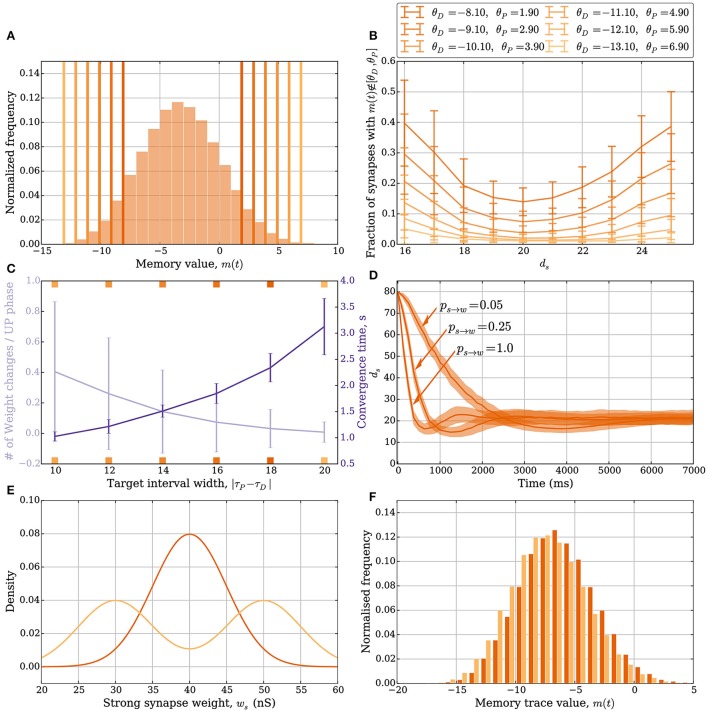
Plasticity vs. stability in the model with leak (Section 3.2.1). (A) Distribution of the memory trace in a static setting, with ps→w = pw→s = 0 and ds = 20 strong input synapses. The colored vertical bars represent the target interval [θD, θP] used in (B,C). (B) The mean fraction of synapses whose memory trace lies outside the interval [θD, θP] in a static setting. (C) The trade-off between the number of weight changes in the stable state and convergence time to the stable state. The light purple curve shows the mean number of weight changes per UP phase over all input synapses. The dark purple curve shows the mean time for the weights to converge from ds = 80 to ds = 25. The ticks on the x-axis are colored and correspond to the thresholds in (A) and curves in (B). In this setup, the number of strong synapses in the stable state is ds = 20. This is achieved by choosing ps→w and pw→s such that they satisfy the equation dsps→w = (d − ds)pw→s; i.e., pw→s = 0.0625 and ps→w = 0.25. The error bars represent standard deviation estimates. (D) Comparison of the effect ps→w and pw→s have on convergence. In this figure, θD = −5.1 and θP = −1.1, and three different values of pw→s (0.05, 0.25, and 1.0) are compared (the corresponding ps→w values are 0.01, 0.06, and 0.25). If too many synapses change their weight simultaneously because of a small target interval and large weight change probabilities, then the weights can overshoot the stable state and oscillate around it. (E,F) Stability for different weight distributions. (E) Density function for two different weight distributions of the strong synapses. The dark orange is the density function of N(40,5), and the light orange is the density function for the random experiment, where we either draw the weight from the distribution N(35,5) or N(45,5) based on a fair coin toss. (F) The corresponding memory trace distribution for each weight distribution when ds = 24 in a static setting with ps→w = pw→s = 0. By choosing θD = −16 and θP = 5, the weight remains unchanged for both weight distributions over a period of 50 s and oscillating input (data not shown). In (A) the distribution is obtained by sampling memory traces of all d synapses after a simulation of 500 UP phases in 250 trials. In (B) each data point is the mean of 100 trials. In (C) each curve is the average over 40 trials. In (D) each curve is the average over 200 trials with a data point every 125 ms. For all panels, error bars and envelopes represent standard deviation estimates. In (F) the distribution is sampled from 100 synapses over 200 trials of a 50 second simulation.